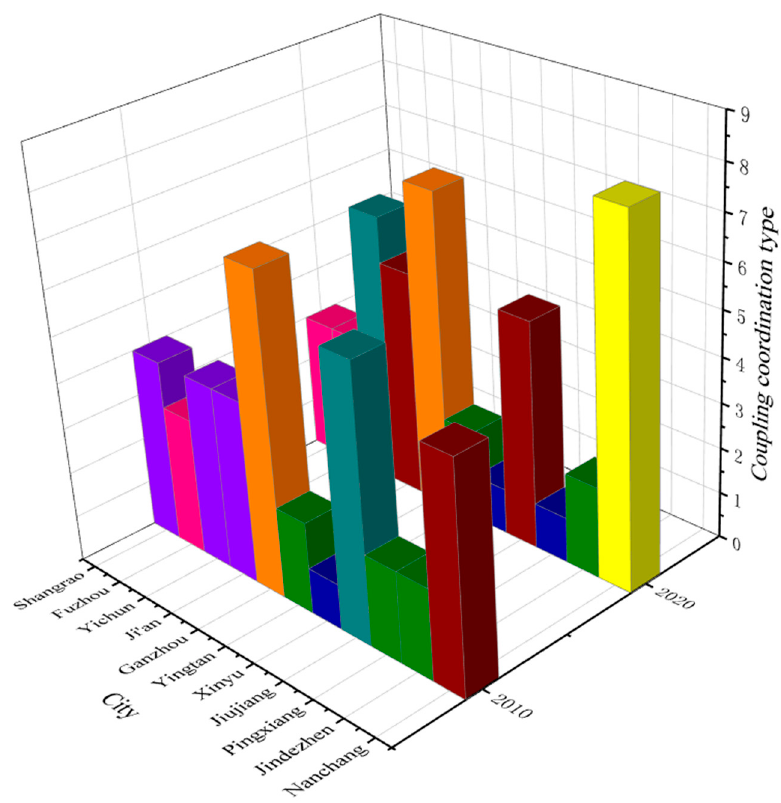
Figure 6. Changes in the degree of coordinated development of GEP and economic coupling in pre- fecture-level cities in Jiangxi Province in 2010 and 2020 (1: Moderately disordered—ecological